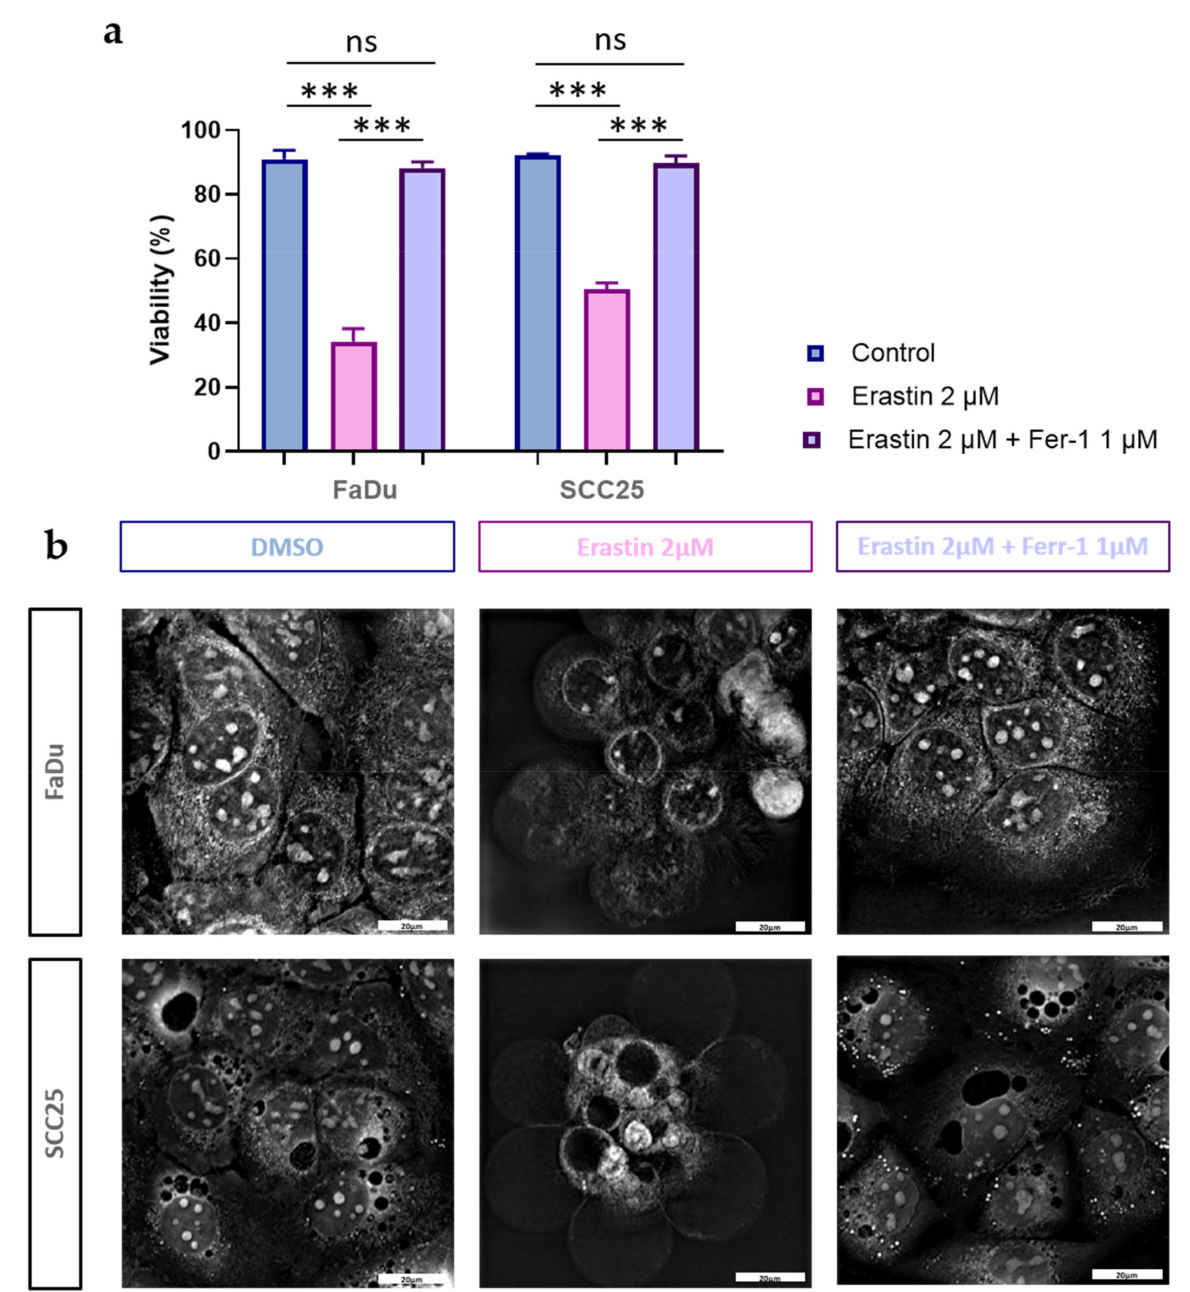
Figure 4. Effects of erastin and ferrostatin-1 on viability and morphology of HNSCC cells. Cell viability was determined in FaDu and SCC25 cells at 72 h after treatment with erastin (2 µ M) or com- bination of erastin (2 µ M) and ferrostatin-1 (1 µ M). DMSO was used as a vehicle control. Columns represent the mean + SEM calculated after at least three independent experiments, *** p < 0.001 ( a , b ) Morphological characteristics of ferroptotic cell death in HNSCC FaDu and SCC25 cells were evaluated using holotomographic microscopy (Nanolive SA 3D-Explorer-FLUO, Tolochenaz, Switzer- land) as described in Materials and Methods. Cells were treated with erastin (2 µ M) or a combination of erastin (2 µ M) and ferrostatin-1 (1 µ M), and at 72 h after treatment, the representative images were obtained; 60 × magnification, bar: 20 µ